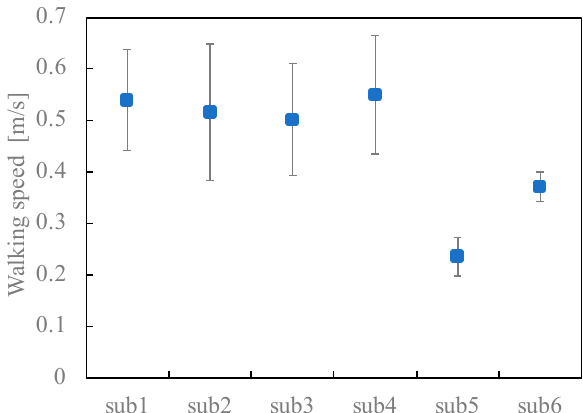
0 Figure 6. Comparison of the ascent speed between participants. Blue circles and error bars indicate the mean values and standard deviations, respectively. Table 3. Stair ascent and descent speed for each